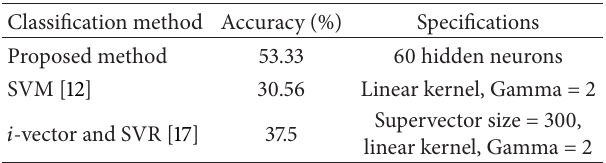
Table 6: A comparative result of the proposed method and the baseline system for age